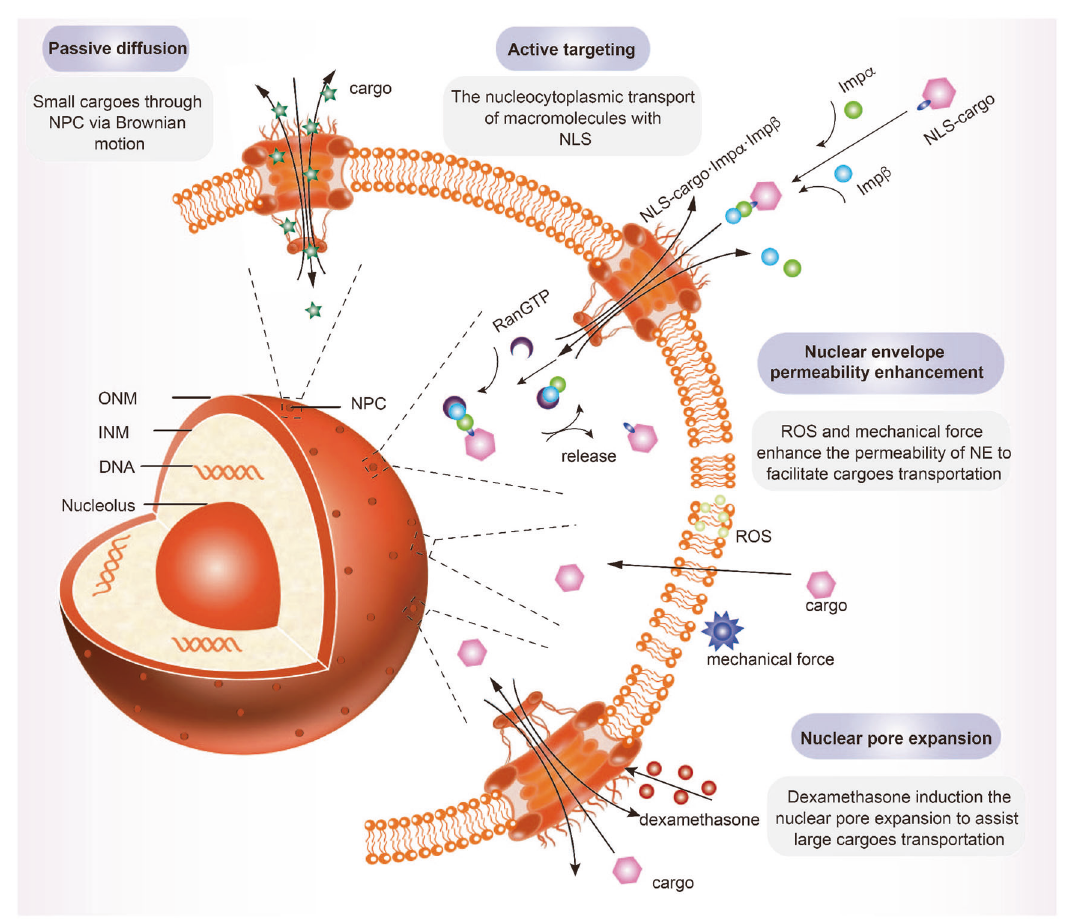
Fig. 3 Design guidelines of nuclear-targeted nanosystems. Small cargoes cross the nuclear envelope through passive diffusion, without interaction with NPC. Active targeting is necessary for large cargoes. NLS-cargoes interact with nuclear transport receptors to achieve large cargoes accumulation in the nucleus. Nuclear envelope permeability enhancement allows ROS and mechanical forces to enhance the permeability of the nuclear envelope, and thus facilitate large cargo nuclear transportation. Nuclear pore expansion is a direct manner that dexamethasone regulates to expand the size of NPC. INM inner nuclear membrane, ONM outer nuclear membrane, NPC nuclear pore complexes, NLS nuclear localization signal, Imp α importin α , Imp β importin β , RanGTP Ran guanosine